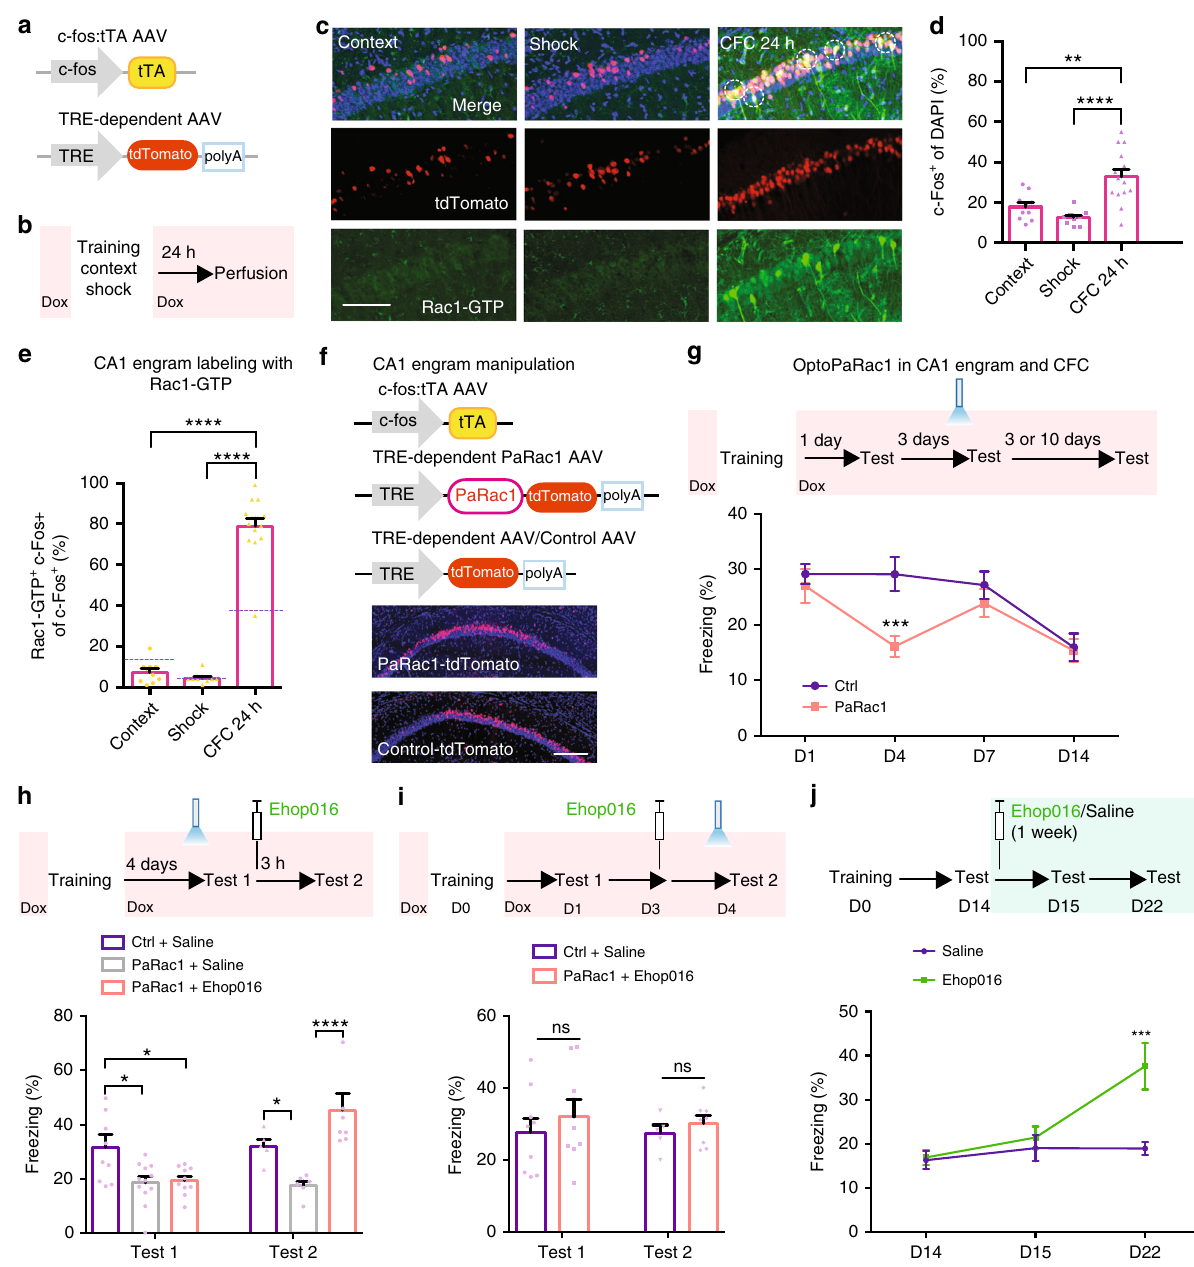
Fig. 2 Regulation of Rac1 activity within CA1 engram cells affects memory maintenance. a – d Strategy of CFC-activated CA1 engram cells labeling with Rac1 activity immunoreactivity. a Diagram of AAV 9 -c-fos:tTA or AAV 9 -TRE-tdTomato. b Experimental schedule. c Coronal section of CA1 engram cells (red) labeling with anti-Rac1-GTP (green). Scale bar, 100 μ m. Circled cells represent examples of double-positive. d Percentages of engram cells in CA1. ** P < 0.01 and **** P < 0.0001 (from one-way ANOVA); n = 10, 9, 14 mice. e Percentages of CA1 engram cells labeling with anti-Rac1-GTP. Chance levels, indicated by grape dashed lines, were estimated at 14.2% (context), 5.1% (shock), and 38.2% (CFC 24 h). **** P < 0.0001 (from one-way ANOVA); n = 10, 9, 14 mice. f CA1 engram cells express PaRac1. Diagram of AAV 9 -c-fos:tTA, AAV 9 -TRE:PaRac1-tdTomato, and AAV 9 -TRE-tdTomato (top), and coronal section of the hippocampal CA1 region with PaRac1-tdTomato (red) (bottom). Scale bar, 300 μ m. g – i Experimental schedule (top) and time courses